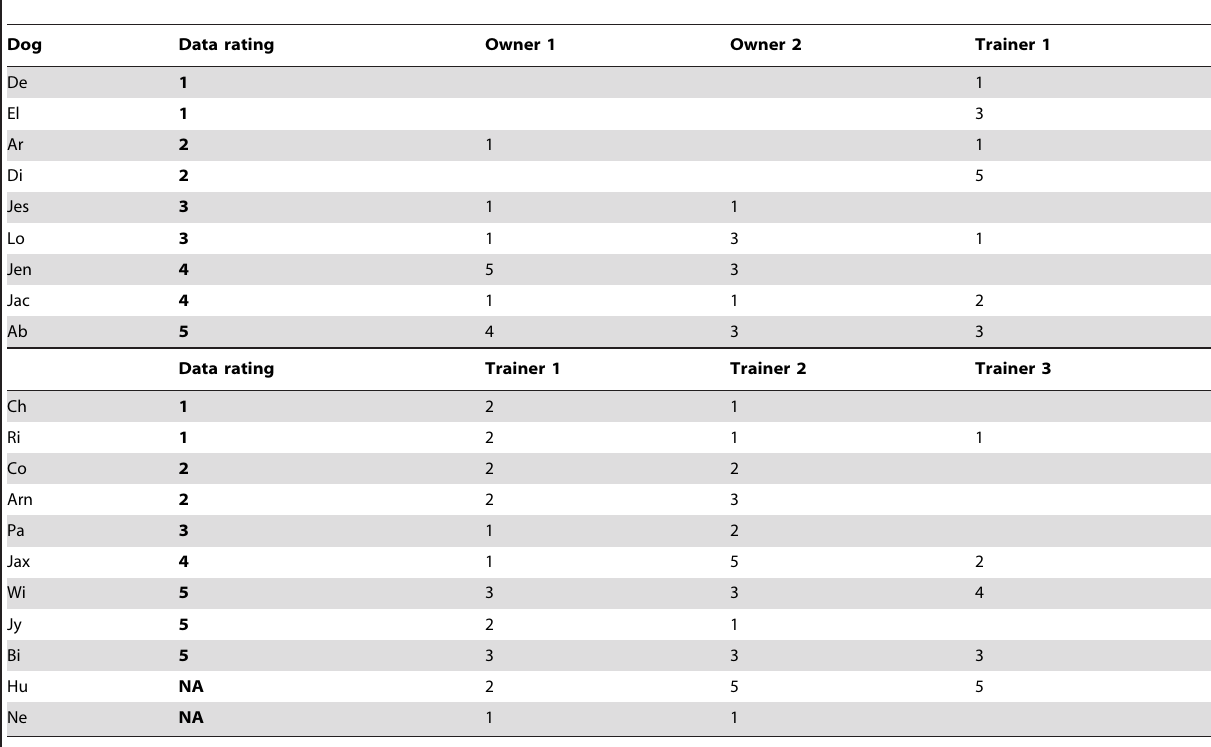
Table 8. Subjective ratings of dog optimism from owners (n= 11) and trainers (n=11).